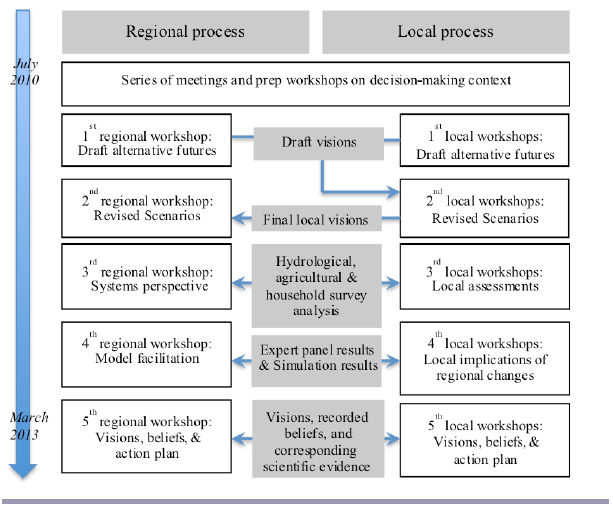
Fig. 3 . Design and implementation steps in the Challenge and Reconstruct Learning (ChaRL) participatory